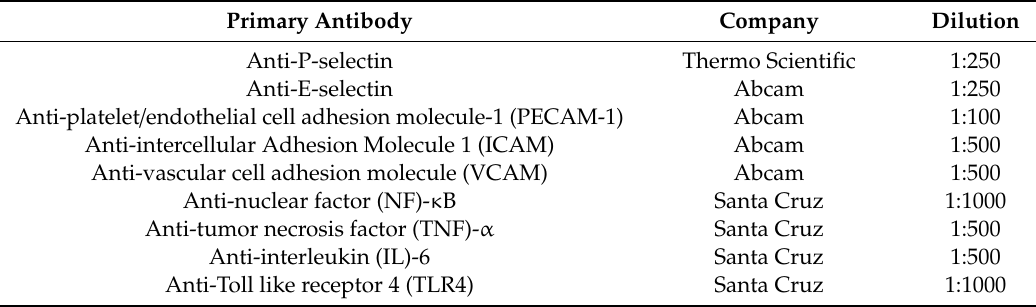
Table 1. Primary antibodies used in the